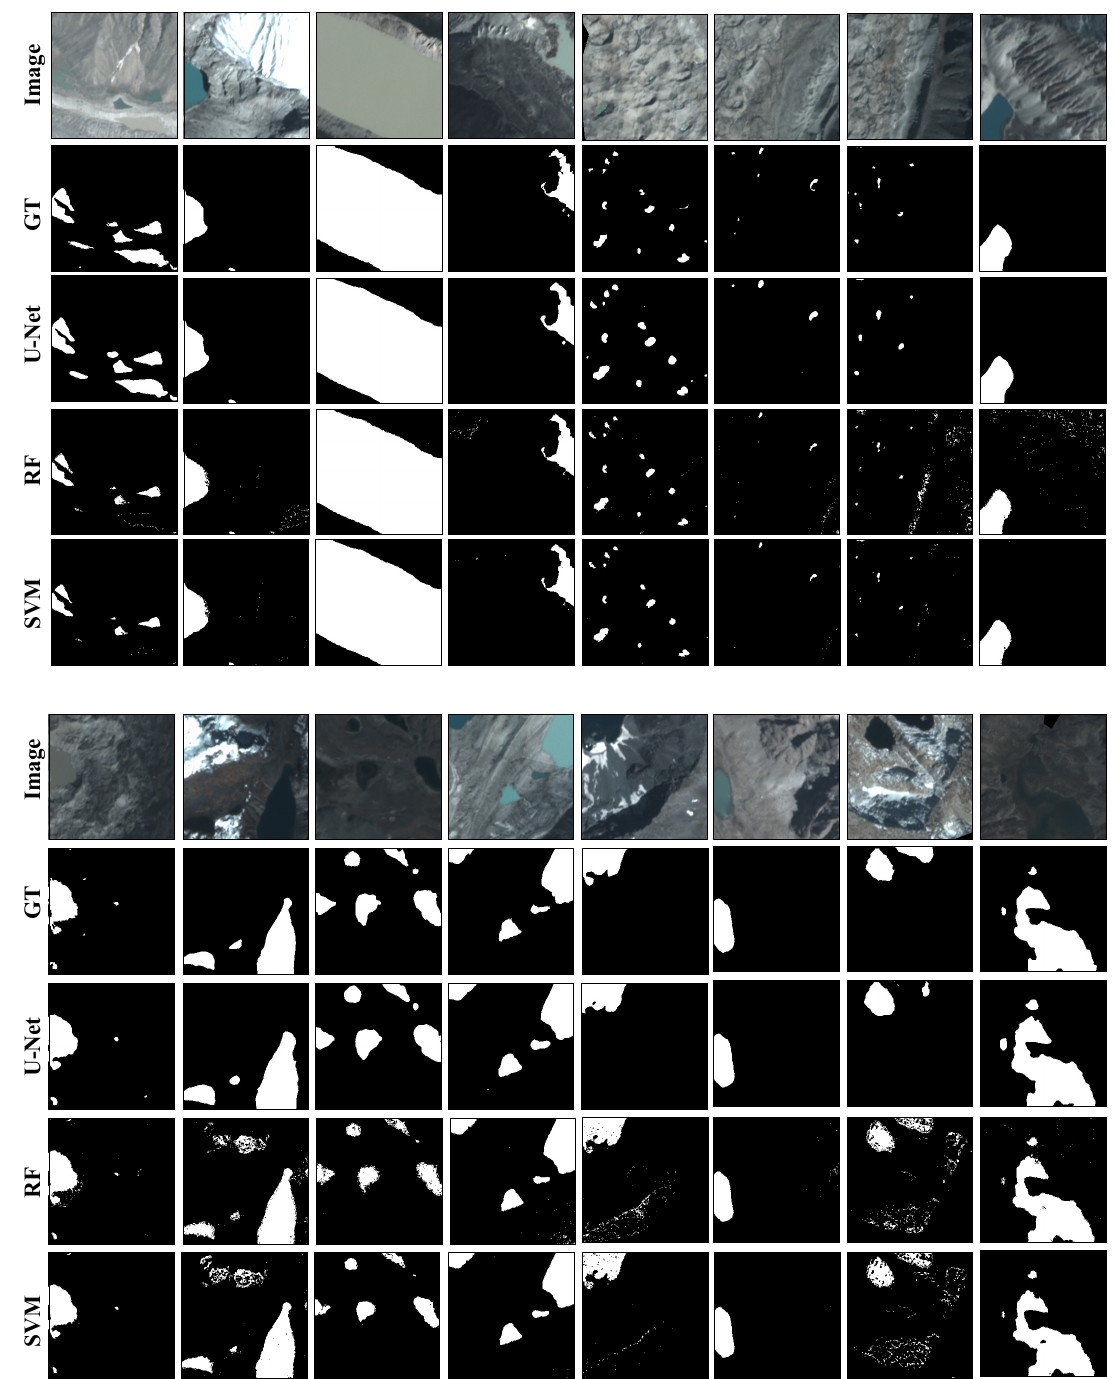
Figure 6. The predicted masks from the U-Net, RF and SVM classifiers shown along with the corresponding ground truth masks for 16 tiles (out of 1311) of the test